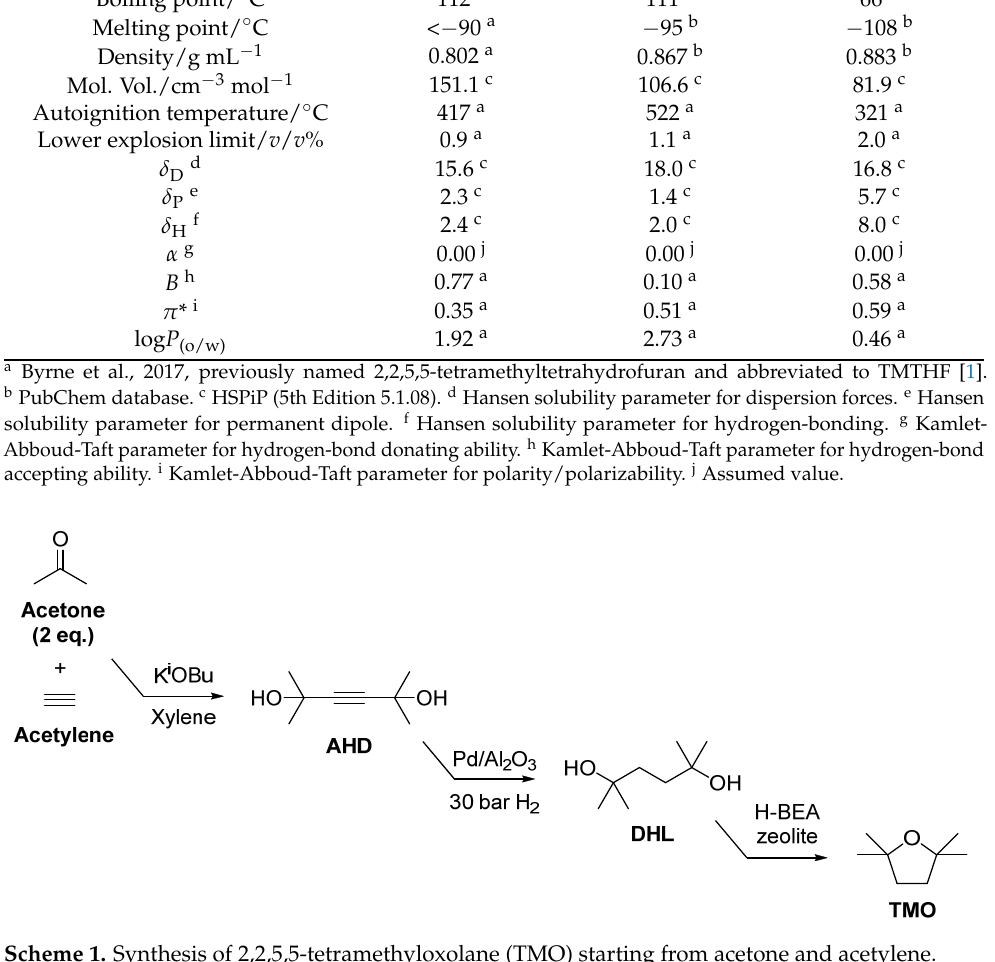
2 Table 1. Properties of TMO compared to toluene and